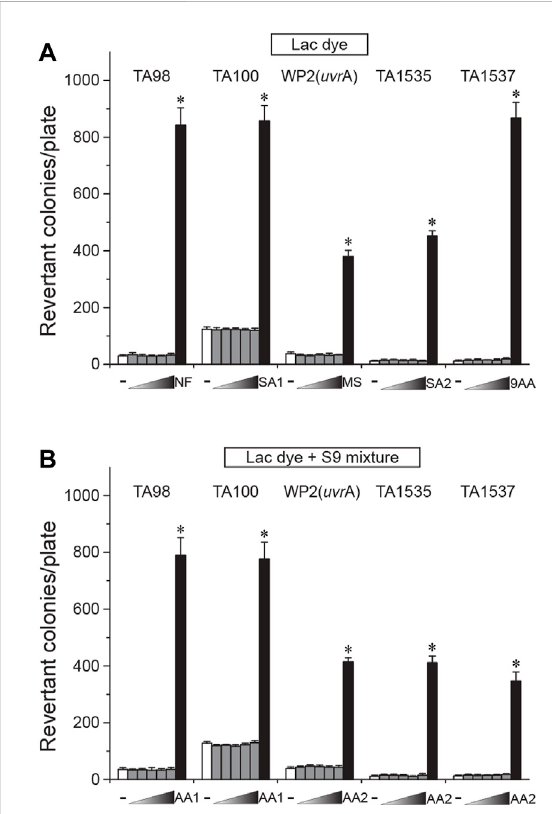
FIGURE 4 Lack of in vitro clastogenicity in lac dye. Lac dye (LD) was tested for clastogenicity using Chinese hamster lung (CHL) cells. (A) Whentestedforcytotoxicityusingrelativepopulationdoubling, LD showed higher cytotoxicity by increasing incubation time while metabolic activation resulted in a marked reduction. (B) The selected sublethal doses for each condition (375, 750, and 1500 μ g/ml for 6-h treatment; 125, 250, and 500 μ g/ml for 24-h; and 625, 1250, and 2500 μ g/ml for 6-h with S-9 mixture) did not increase the number of cells containing aberrant chromosomes, while the positive control group showed a signi fi cant increase. White bars, vehicle control; gray bars, lac dye; and black bars, positive controls (MC1, 0.1 μ g/ml mitomycin C and CP, 5.0 μ g/ml cyclophosphamide). Negative signs indicate the vehicle